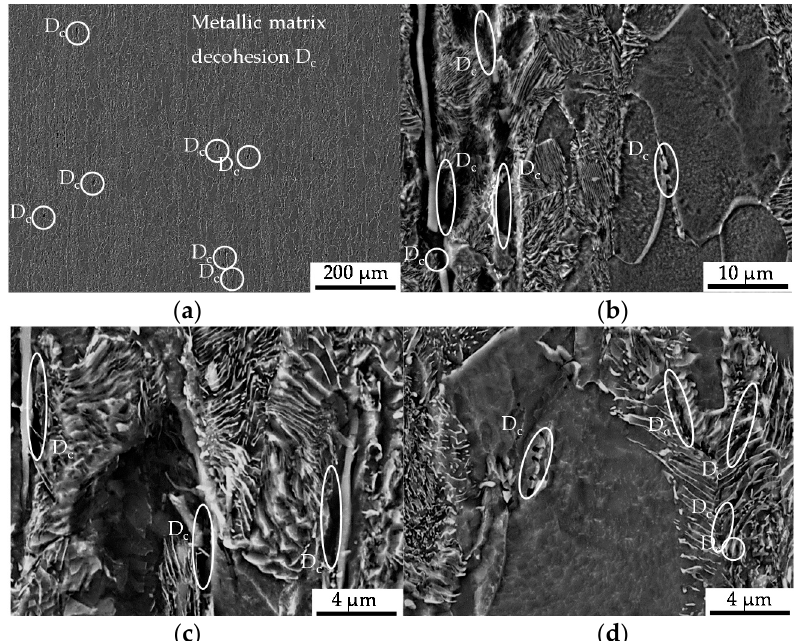
Figure 7. Cyclic damage (D c ) induced under cyclic compression load paths: ( a ) overview of the ferrite–pearlite microstructure giving a representation of the quantity of cyclic load-induced cyclic damage in the form of metallic matrix decohesion and a subpicture of detailing; ( b ) detailed view of pore-coalescence at MnS-inclusions clustered in the pearlite phase ( left ), and grain boundary decohesion ( right ); ( c ) detailed view of the interface decohesion between the metallic matrix and MnS-inclusions; ( d ) Fe3C-cracking ( left ), and cracks grown in grains belonging to the pearlite material phase ( right ). In the bulged area of the specimen, which is characterized by a non-uniform stress state due to bulging, the deformation of MnS-inclusions in the bulging direction accompanied by the decohesion of the metallic matrix and the MnS-inclusions decohesion was observed (see Figure 8). The grains belonging to the ferrite phase showed no mesoscopic signs of cyclic fatigue damage.